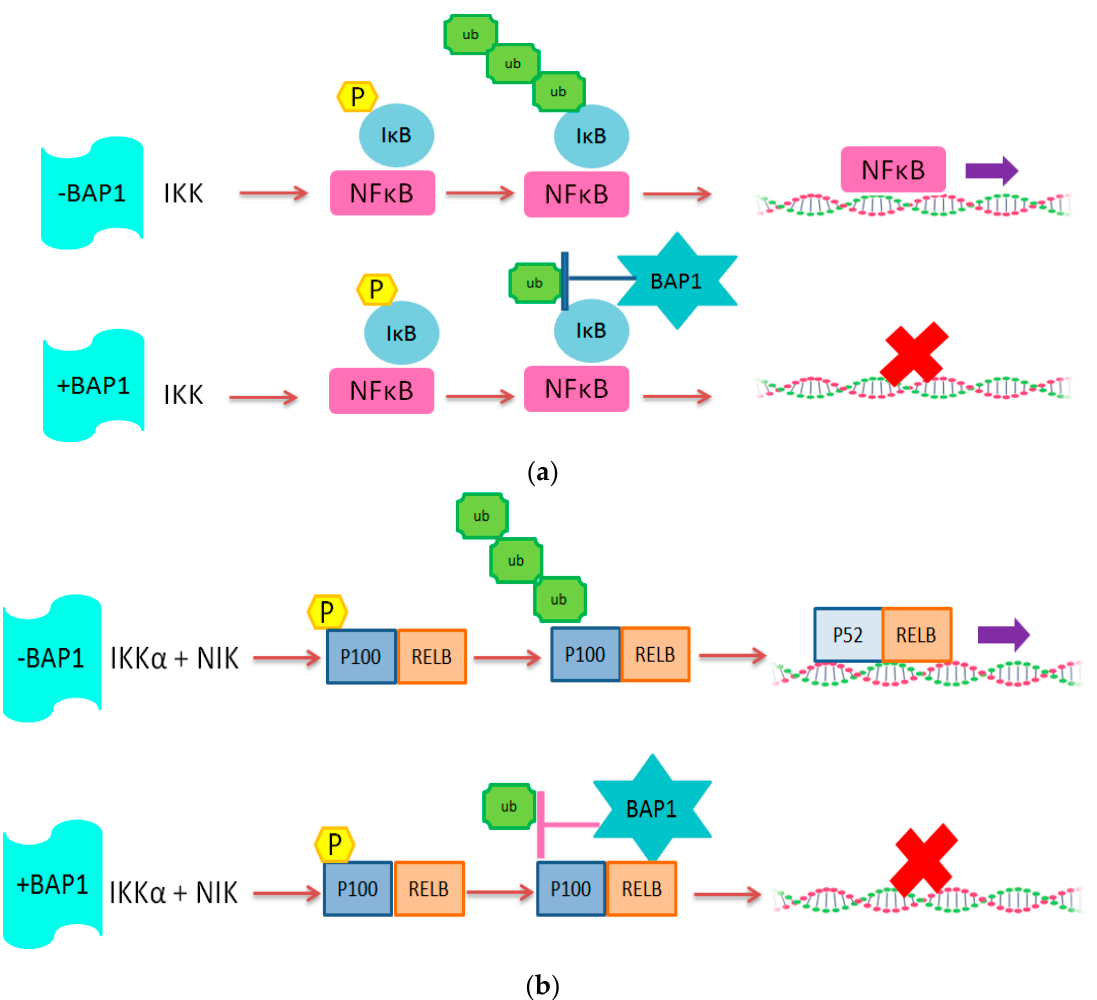
Figure 4. Schematic illustration of the potential role of BAP1 protein in ( a ) Canonical and ( b ) non-Canonical NFkB pathway. We propose that BAP1, as a deubiquitinating enzyme, inhibits NFkB activity.